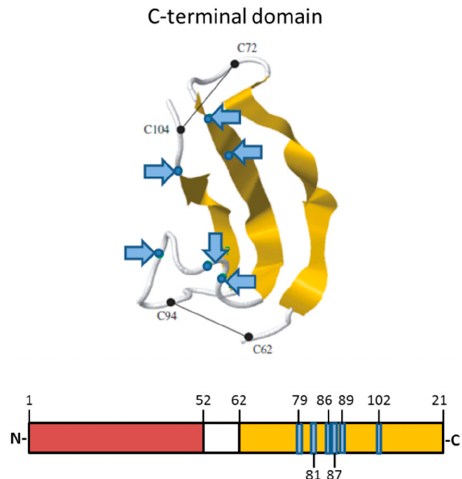
Figure 1. Protein structure of midkine (MK). The protein consists of an N-terminal domain (red) and a C-terminal domain (yellow), which are connected by a hinge region (white). The heparin-binding domains, which consist of basic amino acids, are located in the C-terminal domain (labeled in blue, blue arrows). Adapted from Weckbach et al. 2011 [6], with the permission of the authors . MK together with pleiotrophin (PTN) forms its own so-called MK family [17], which is structurally not related to any other protein family. Both proteins show a 50% sequence identity and